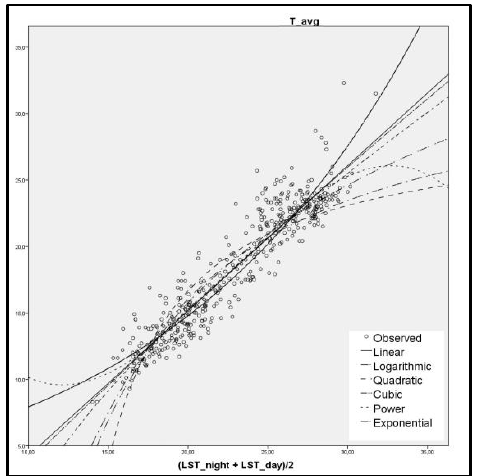
Figure 4. Correlation graph between T avg and the average of Daytime and nighttime MODIS LST.